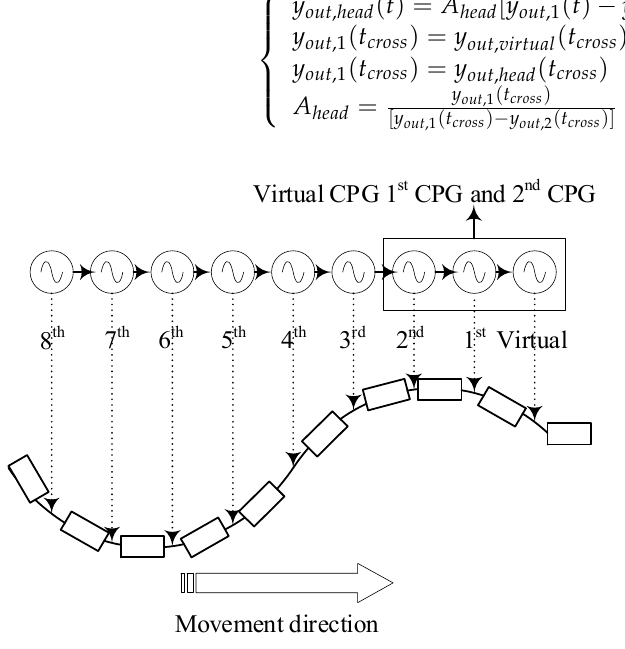
Figure 4. CPG network for controlling head navigation motion.